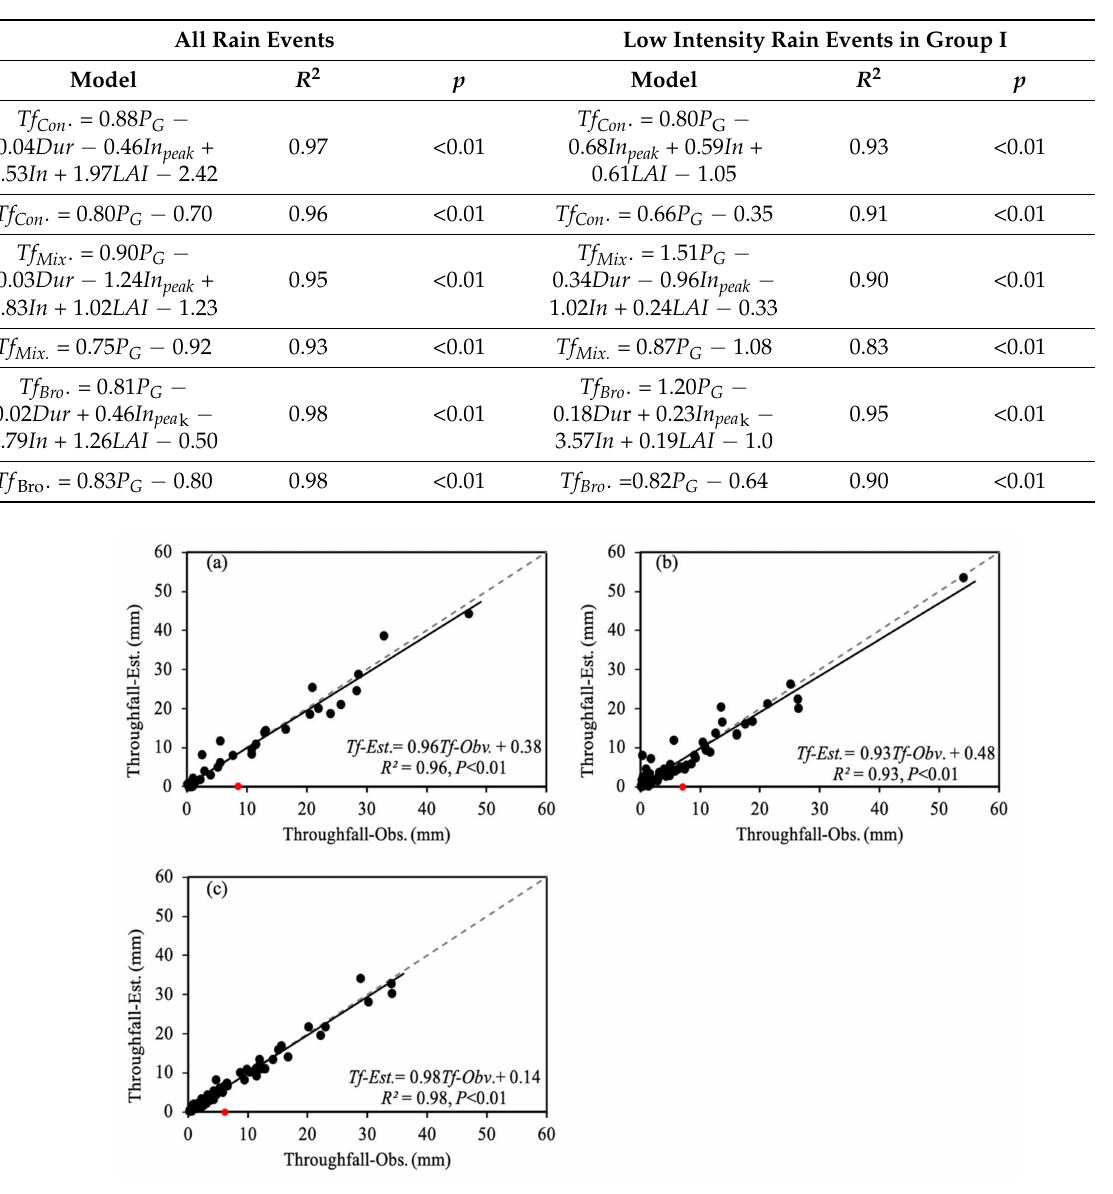
Figure 6. Comparison of the estimated and observed throughfall amount in CF ( a ), MF ( b ), and BF ( c ). Throughfall amount was estimated using the established linear models with rainfall amount as the only variable. Red dots were the critical values for division of overestimation. The dashed lines were the 1:1 line of the estimated and observed throughfall